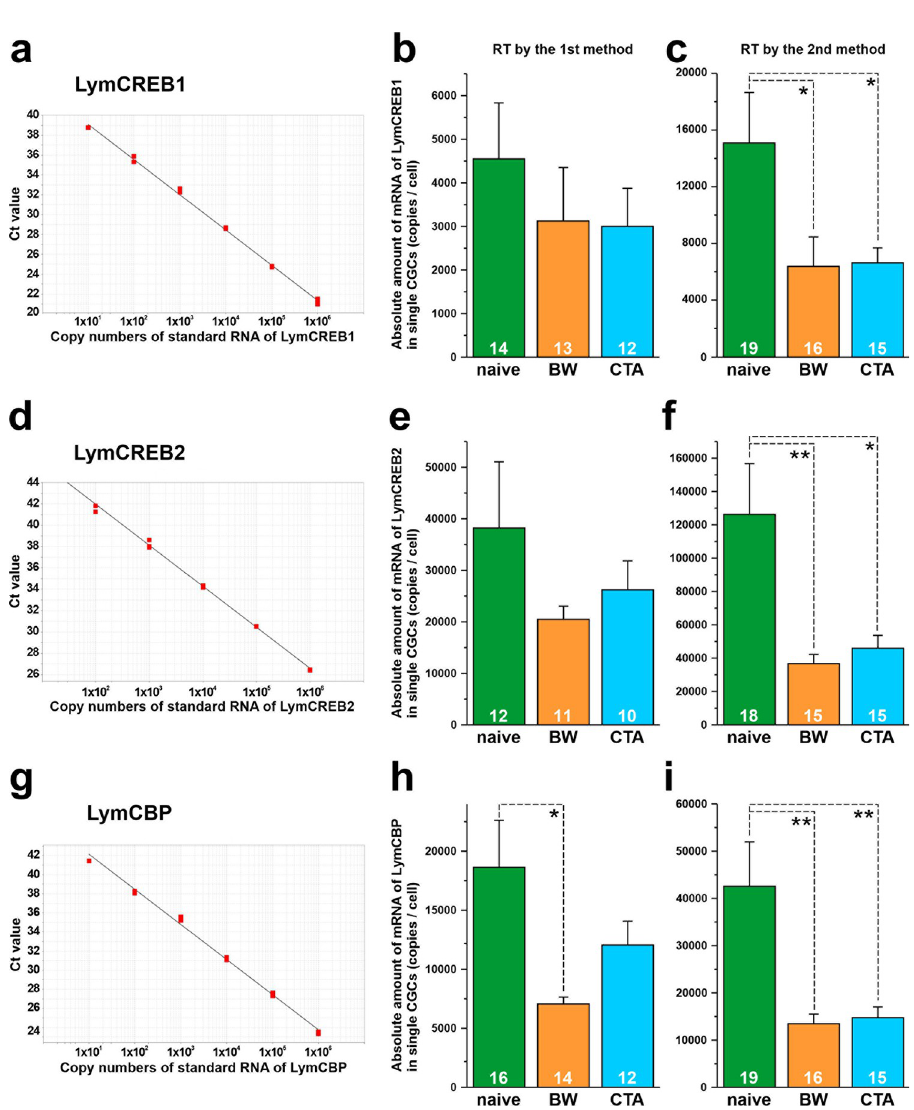
Fig 5. Results of absolute quantification of LymCREB1, LymCREB2 and LymCBP mRNA levels. Standard curves of LymCREB1 (A), LymCREB2 (D), and LymCBP (G). The mRNA levels in the CGCs reverse-transcribed with the mixture of oligo d(T) and random primer (B, E, H) or gene-specific primers (C, F, I). Green, orange, and blue bars show na ï ve-control, BW-trained, and CTA-trained snails, respectively. Quantification data are expressed as mean ± SEM. The results were analyzed using 1-way ANOVA followed by Tukey’s post-hoc test ( � p < 0.05, �� p < 0.01). The number of samples is indicated at the bottom of the bar graph.